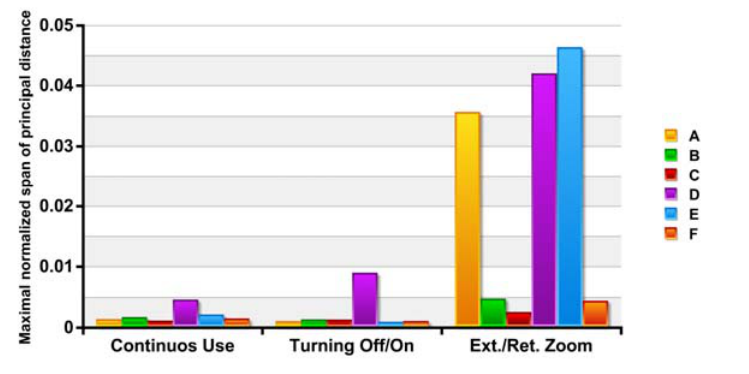
Figure 4. Maximum normalized range of changes in principal distance c. The spans are normalized with the image width.